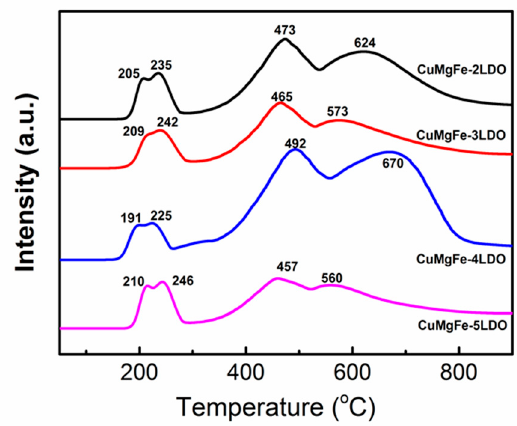
Figure 4. Hydrogen temperature-programmed reduction (H 2 -TPR) profiles of CuMgFe-xLDO cat- alysts.